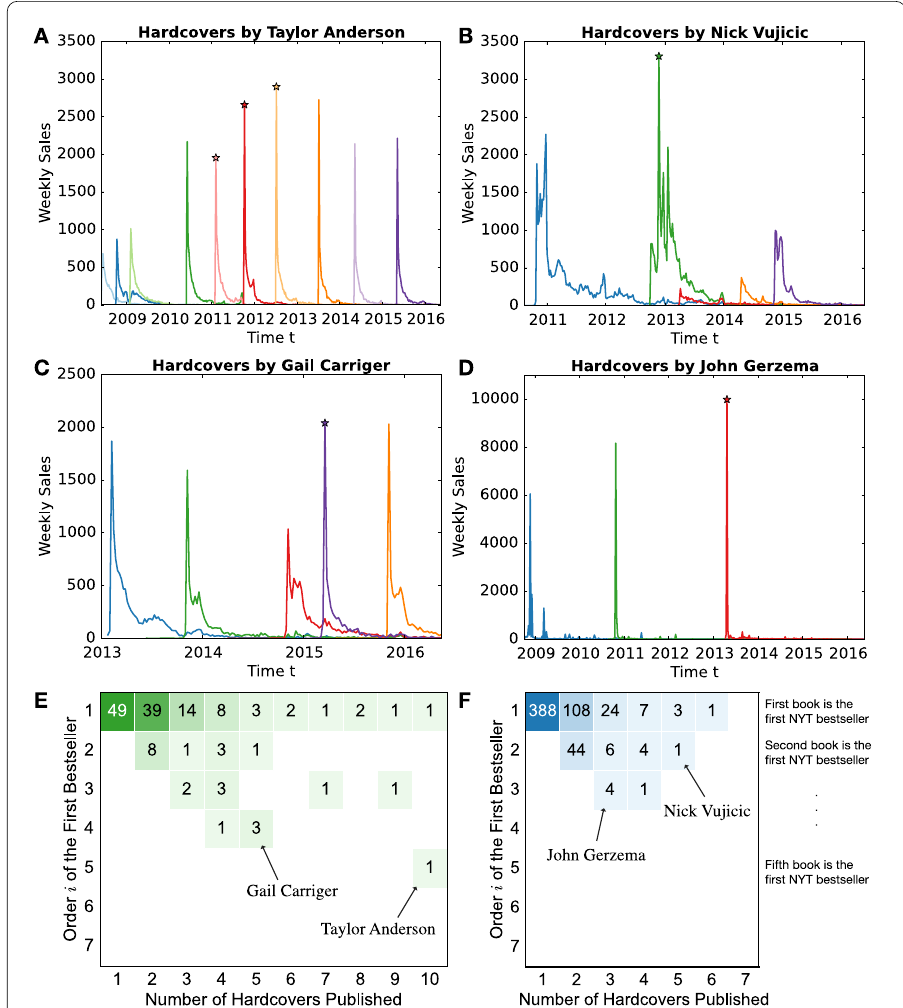
Figure 6 Whendoauthorssucceed? ( A ) The sales history of TheDestroyermen series author Taylor Anderson, showing for each book the weekly hardcover sales. Curves marked with a star on top indicate bestsellers. Same for authors ( B ) Nick Vujicic, ( C ) Gail Carriger and ( D ) John Gerzema. ( E ) Heatmap showing the number of hardcovers a fiction author has published in their career vs the order i of one that became the first bestseller, ( F ) same for nonfiction authors. Only authors who started their career in 2008 and after are considered and boxes the authors shown in ( A )–( D ) belong to are marked accordingly. We see that while most